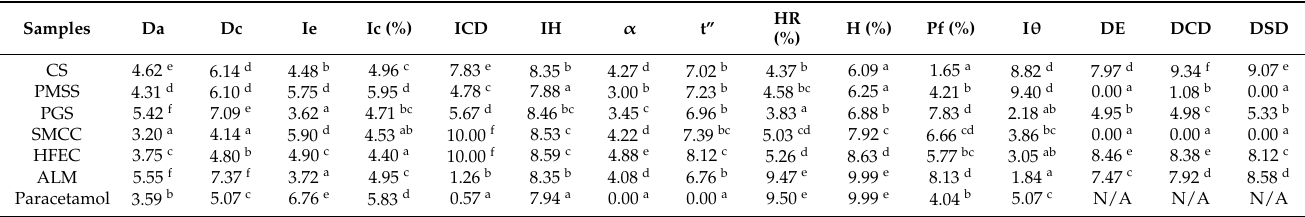
Figure 1. SeDeM-ODT diagrams of CS, PMSS, PGS, and commercial DC excipients, and a SeDeM diagram of paracetamol. Table 1. Parameter radius values of paracetamol and excipients.